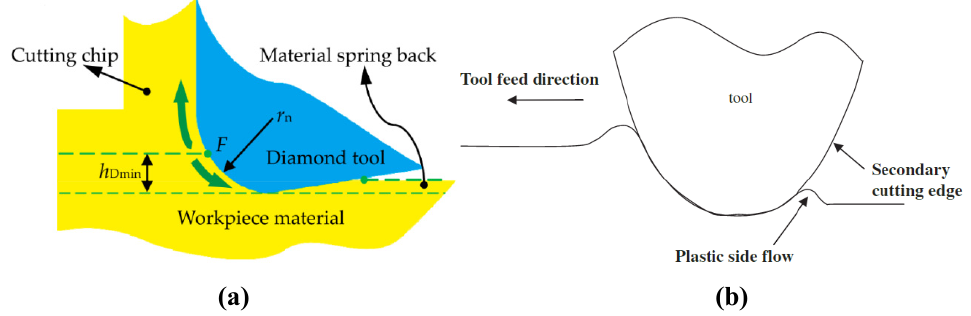
Figure 10. Schematic representation of ( a ) material spring back and ( b ) plastic side flow generated during diamond turning [67,69]. Reprinted with permission from [67,69]; 2018, 2006 Elsevier. Thermochemical wear of diamond tools is another factor which dictates whether a material can be machined through diamond turning or not. Due to the presence of high temperatures between the workpiece and the cutting tool, graphitisation, oxidation and chemical diffusion may occur, subsequently leading to enhanced tool wear and poor surface finish. A number of remedies have been developed to overcome these problems, which include the application of ultrasonic vibrations between the cutting tool and the workpiece, and the introduction of inert gases which help to increase